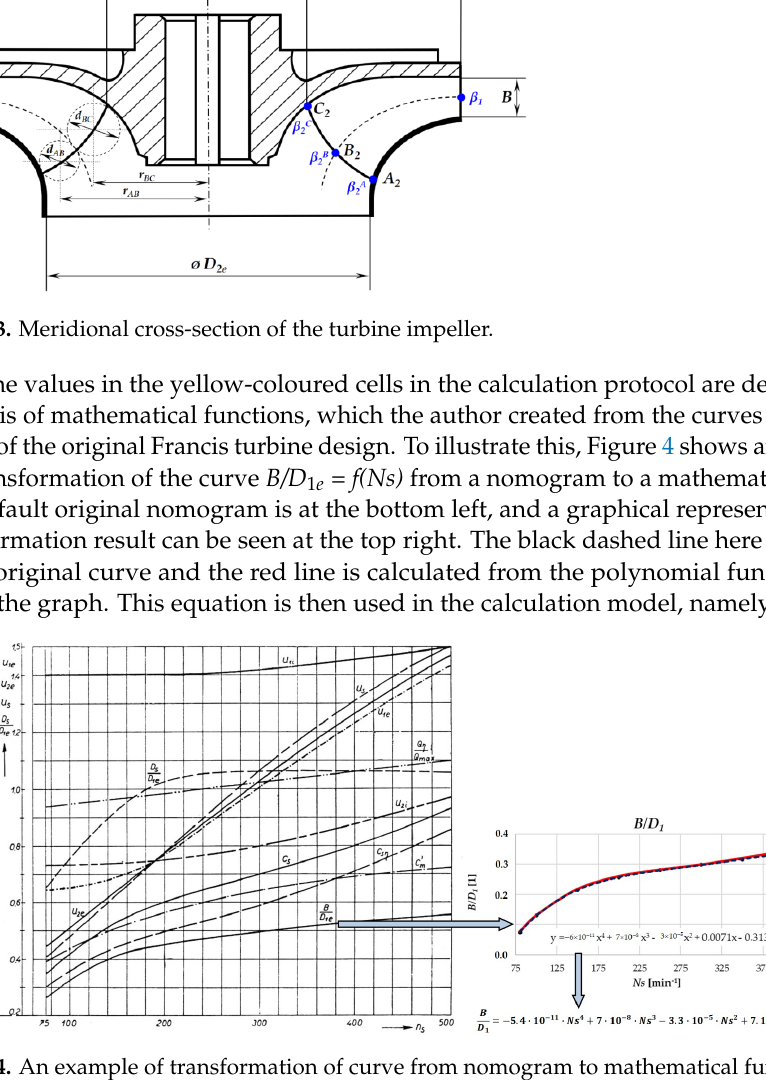
Figure 4. An example of transformation of curve from nomogram to mathematical function. Repro- duced and modified from [18], SNTL Prague: